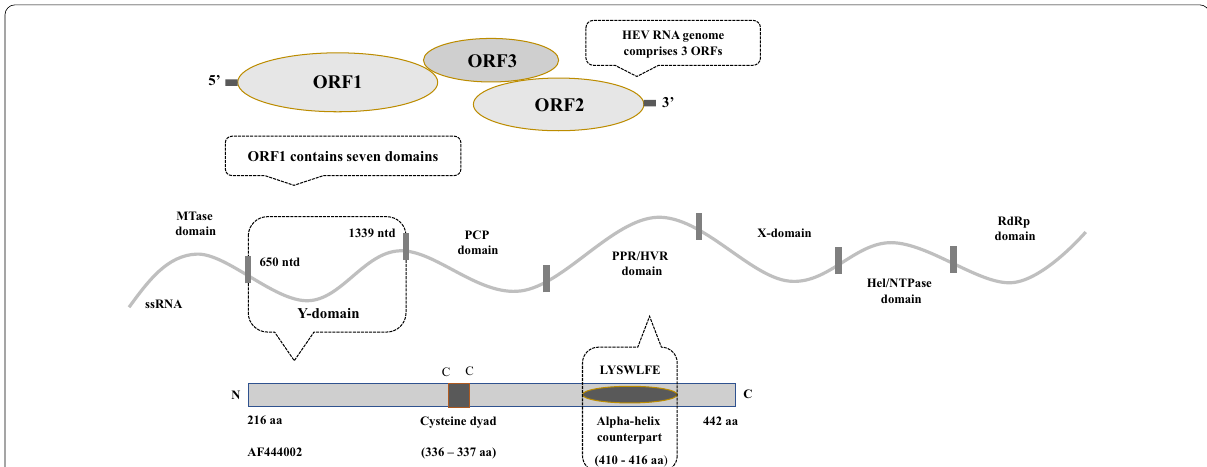
Fig. 1 Diagrammatic representation of the HEV largest non-structural polyprotein (ORF1) showing the Y-domain of HEV. The HEV ORF1 constitutes seven domains which include MTase: methyltransferase; Y: Y; PCP: papain-like cysteine protease; P/HVR: proline-rich/hypervariable region; X: macro; Hel/NTPase: helicase/nucleotide triphosphatase; and RdRp: RNA-dependent RNA polymerase. The Y-domain (AF444002) constitutes 228 amino acids and comprises a potential palmitoylation-site (C 336 C 337 ) and an alpha-helical motif (L 410 Y 411 S 412 W 413 L 414 F 415 E 416